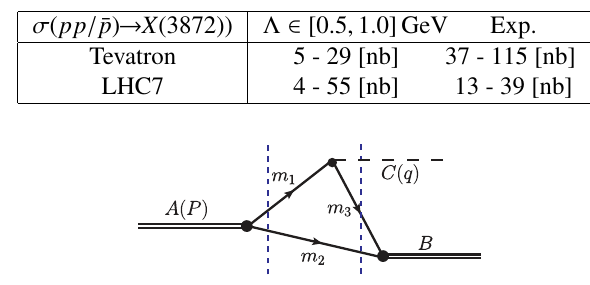
Figure 11. A triangle diagram illustrating the long-distance con- tribution to the transition between two heavy particles A and B with the emission of a light particle C. The two vertical dashed lines denote the two relevant cuts. Figure from